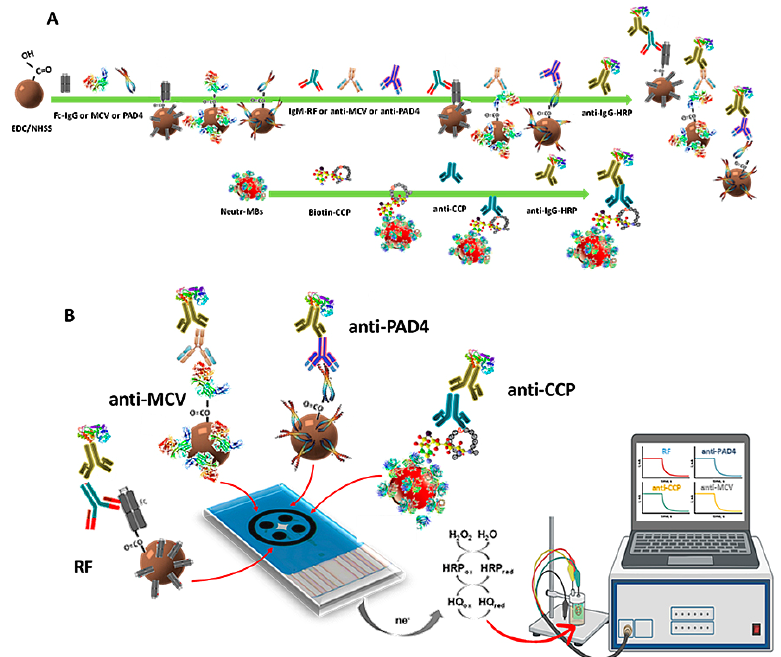
Figure 1. ( A ) Scheme of the steps for the preparation of HRP-IgM-RF-Fc(IgG)-cMBs, HRP-IgG-anti-PAD4-PAD4-cMBs, HRP-IgG-anti-MCV-MCV-cMBs, and HRP-IgG-anti-CCP-CCP-Biotin-Neutr-MBs magnetic immunoconjugates and ( B ) their capture on the SPC4E, as well as the reactions involved in the simultaneous amperometric detection.